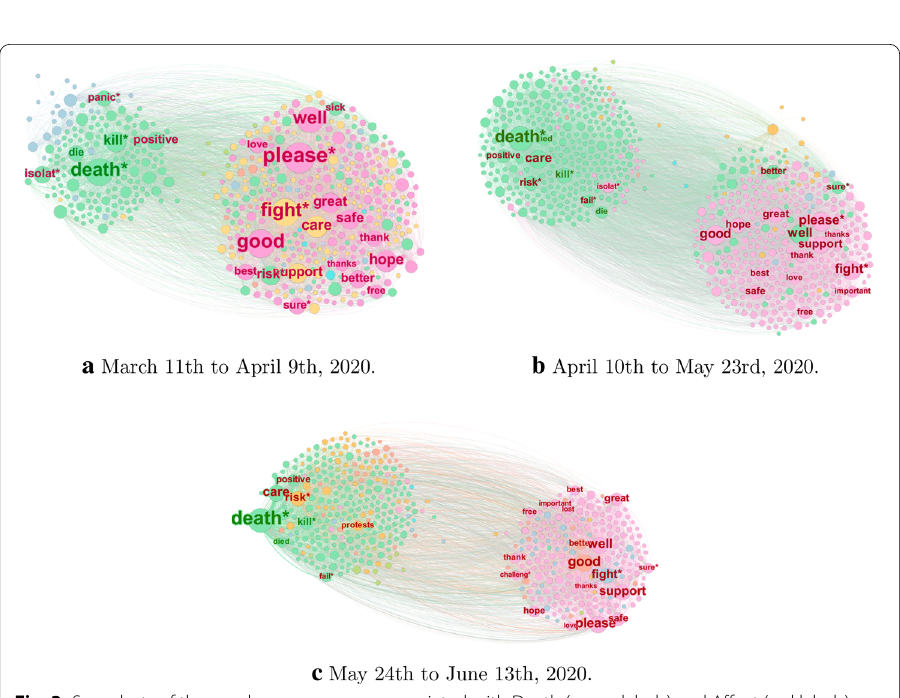
Fig. 3 Snapshots of the word co-occurrences associated with Death (green labels) and Affect (red labels) for English-language tweets aggregated across all analyzed countries in three different time windows (see sub-captions). The nodes are coloured according to their community label as obtained by maximising modularity with the Louvain algorithm (Blondel et al. 2008). We filtered edges with weight below 20 co-occurrences for visualisation